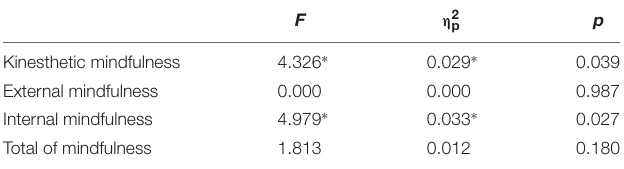
TABLE 4 | General linear model scores